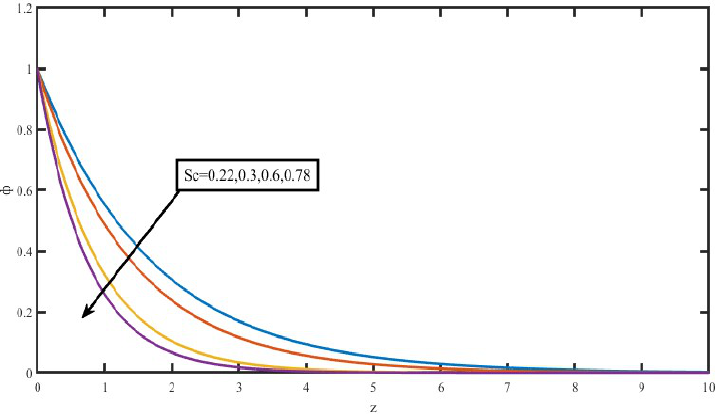
Figure 18. Concentration profiles for Schmidt number (S c ).